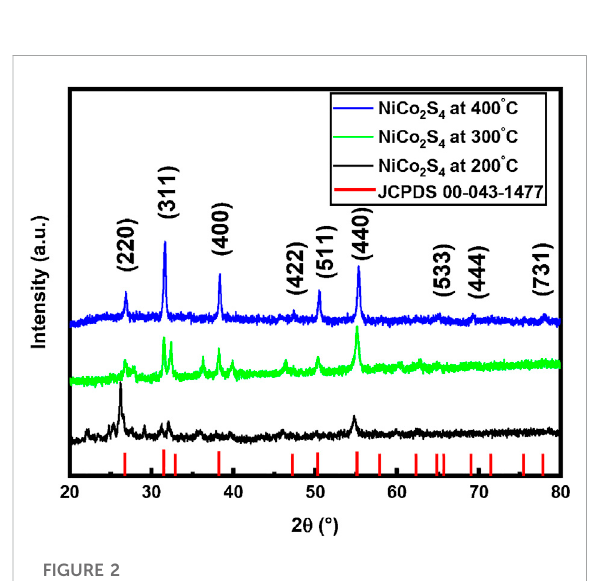
FIGURE 2 XRD spectrum of NiCo 2 S 4 synthesized at different reaction